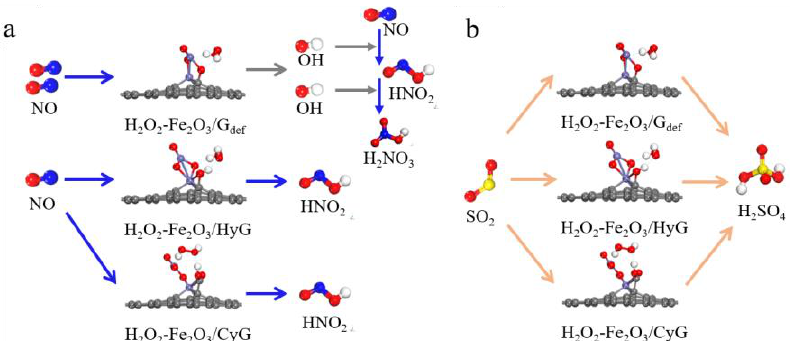
Figure 7. Schematic diagram of the mechanism of ( a ) NO and ( b ) SO 2 oxidation on H 2 O 2 -Fe 2 O 3 /G def , H 2 O 2 -Fe 2 O 3 /HyG, and H 2 O 2 -Fe 2 O 3 /CyG. The C atom is gray, the O atom is red, the Fe atom is purple, the H atom is white, the N atom is blue, and the S atom is yellow.